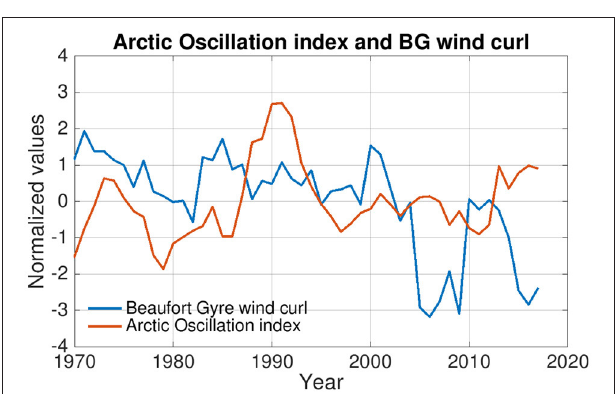
FIGURE 2 | Annual mean Arctic Oscillation index (red) and wind curl over the Beaufort Gyre region (blue). Five years running means are shown. A positive (negative) Arctic Oscillation index is associated with a negative (positive) sea level pressure anomaly over the Arctic Ocean. See also Figure 3 for the spatial pattern of the sea level pressure